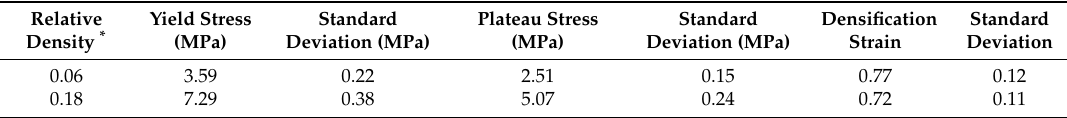
Figure 2. Quasi-static compression stress–strain curves of aluminum foam materials at a strain rate of 0.0005 s − 1 (ram speed of 1 mm/min). ( a ) Specimen; ( b ) stress–strain curves. Table 1. Mechanical properties of the aluminum foams.